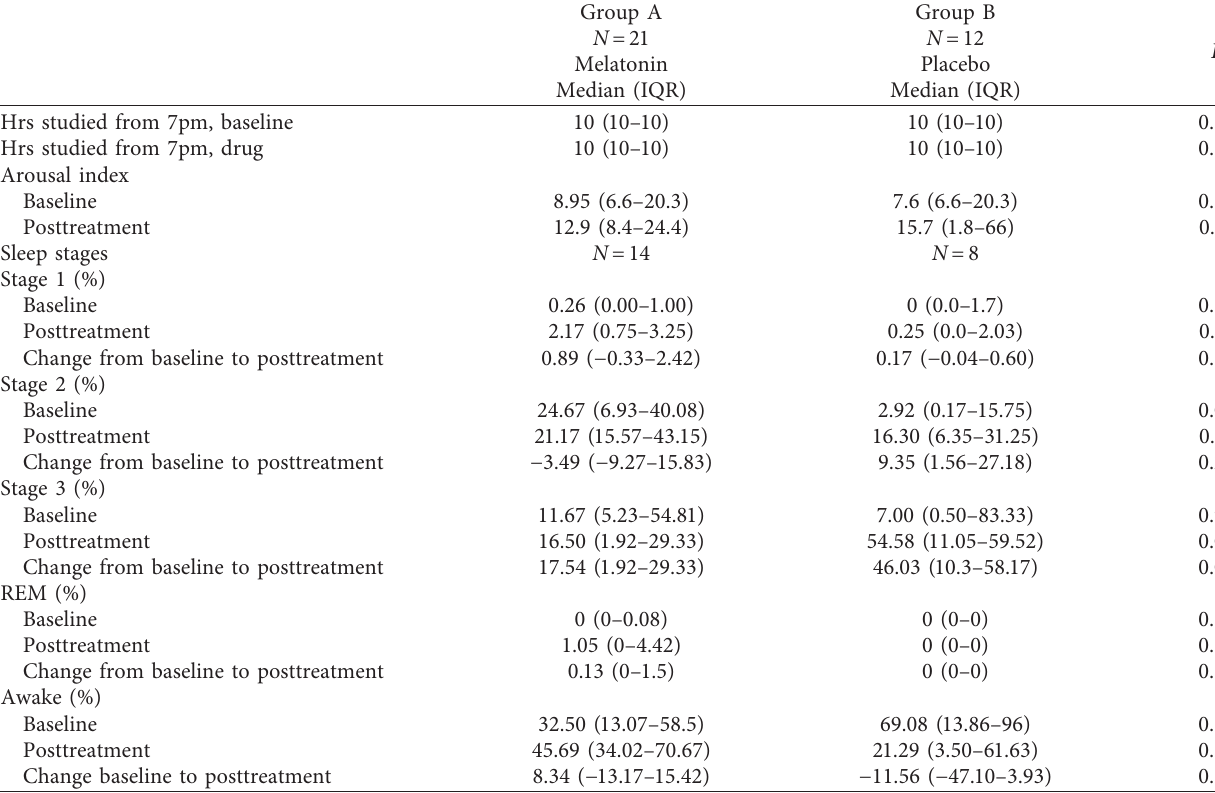
Table 4: Sleep analysis in study